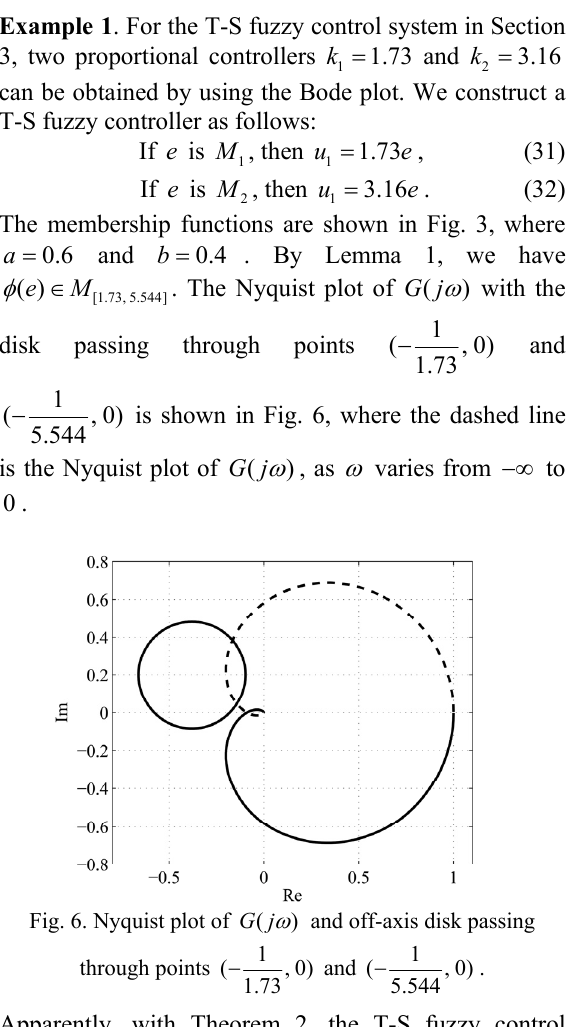
Fig. 8. Nyquist plot of ( ) G j ω and off-axis disk passing − through points ,0) 1.25